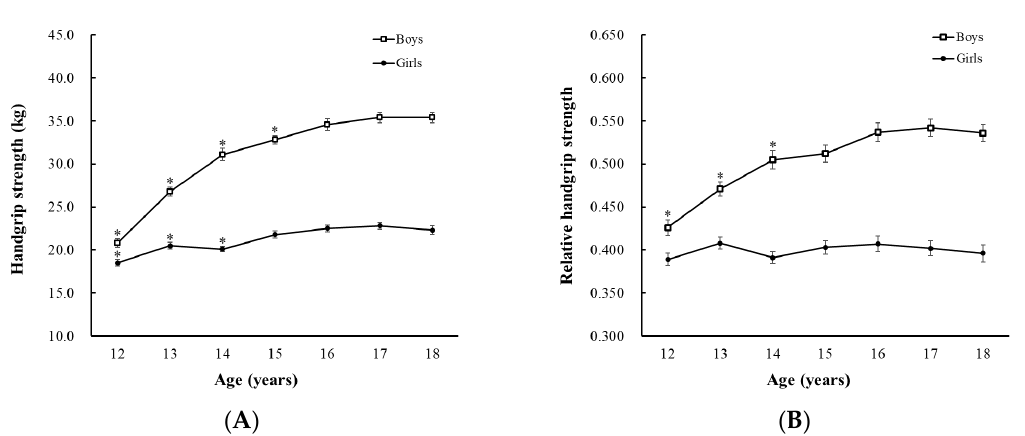
Figure 1. ( A ) Handgrip and ( B ) relative handgrip strength of the study population according to age and sex. Values are weighted means, and error bars represent the standard errors of the means. * p < 0.05 by post hoc analyses, age 18 years old as reference.